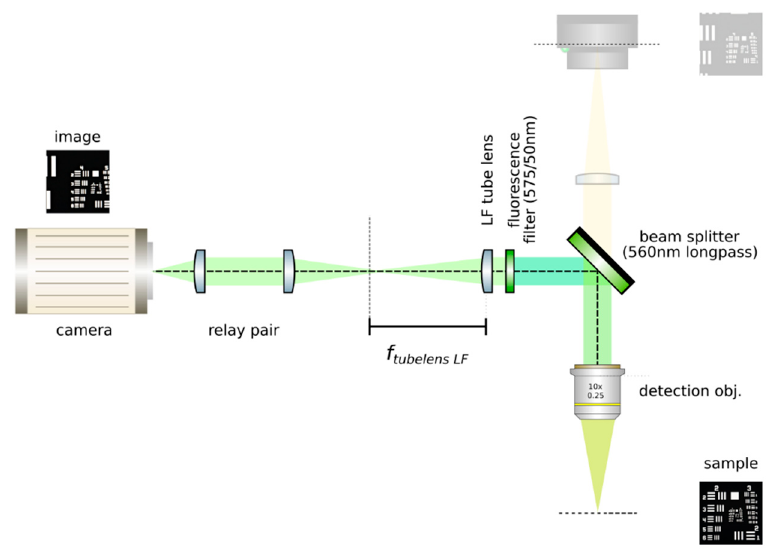
Figure 14. Insert a relay pair. Move the camera backwards and place the relay pair. An image of the sample should appear in focus with the correct magnification (from the relay).